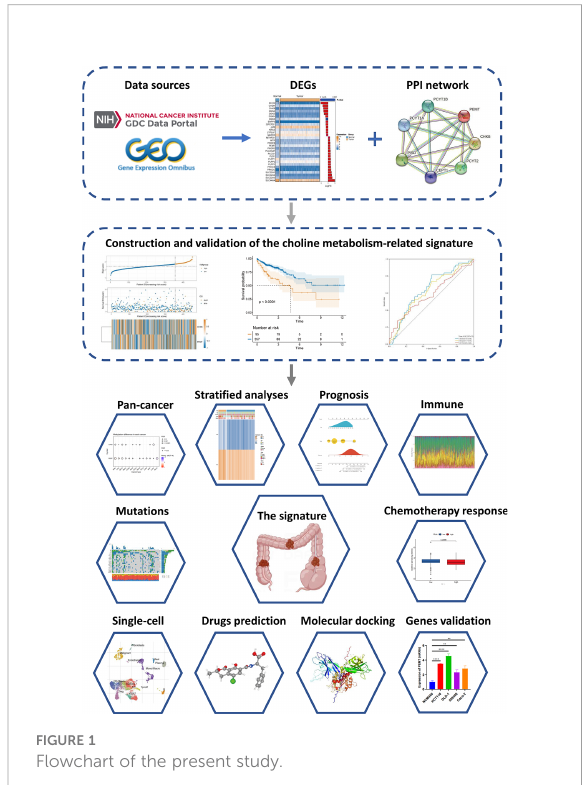
FIGURE 1 Flowchart of the present